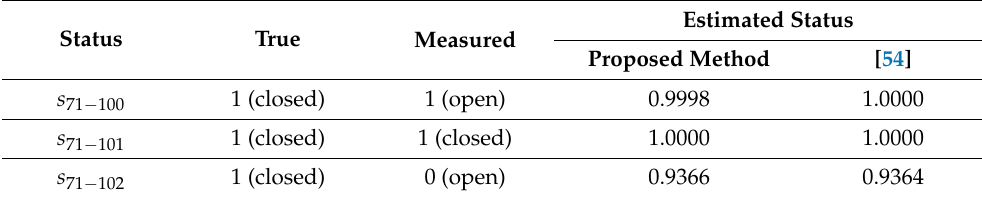
Table 8. True, telemetered, and estimated breaker statuses used for comparison reasons.